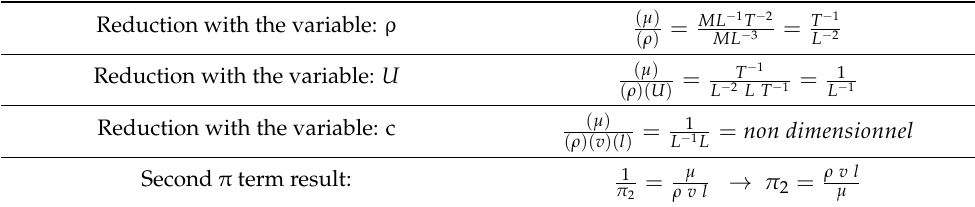
Table 6. Dimensional analysis second term